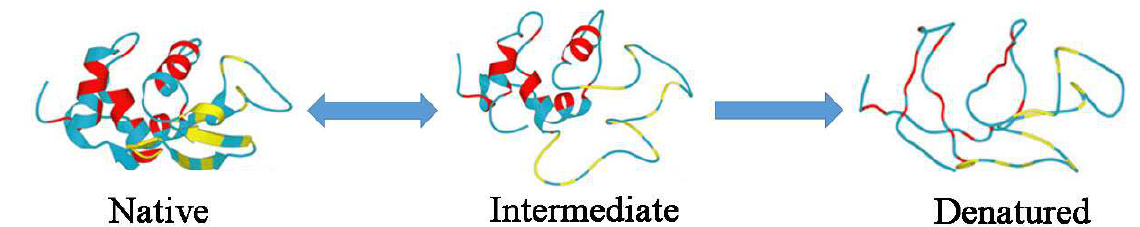
Figure 1. Schematic representation of the three different states of the protein lysozyme. The protein native state can be recovered from the intermediate state, which however, being unstable, can end in the irreversibly denatured state. Figure adapted from Reference [16,17].